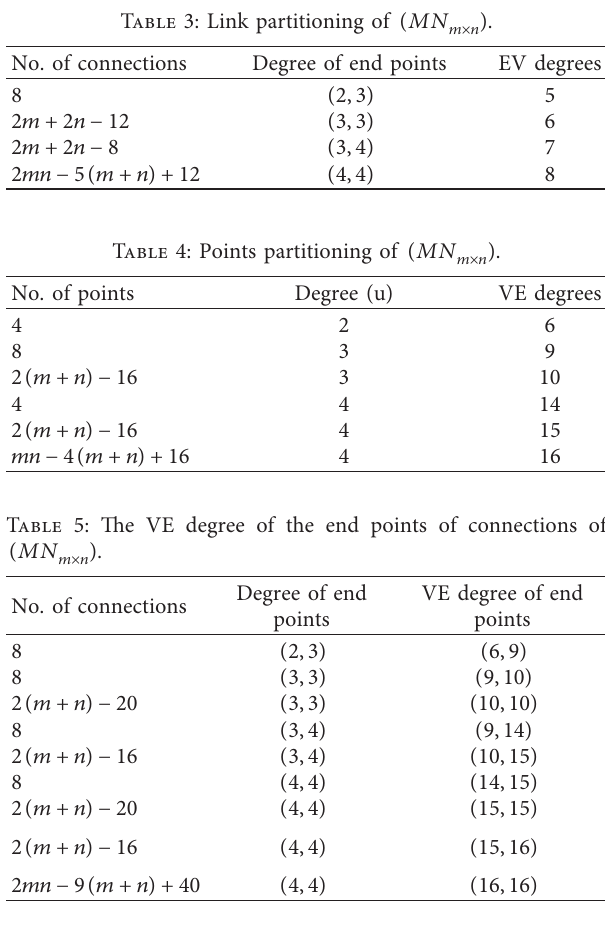
Table 3: Link partitioning of ( MN